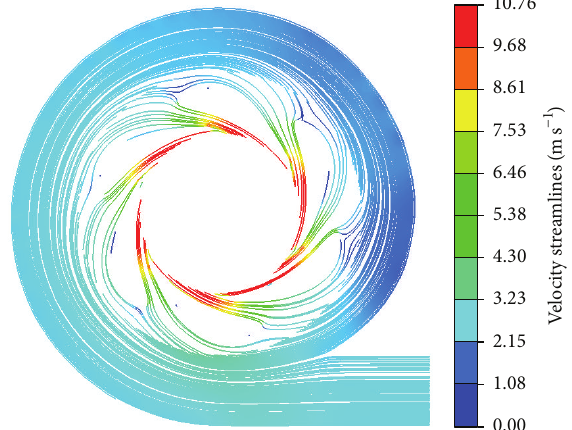
Figure 8: Streamlines at midplane of spiral casing and distributor at operating point (BEP).